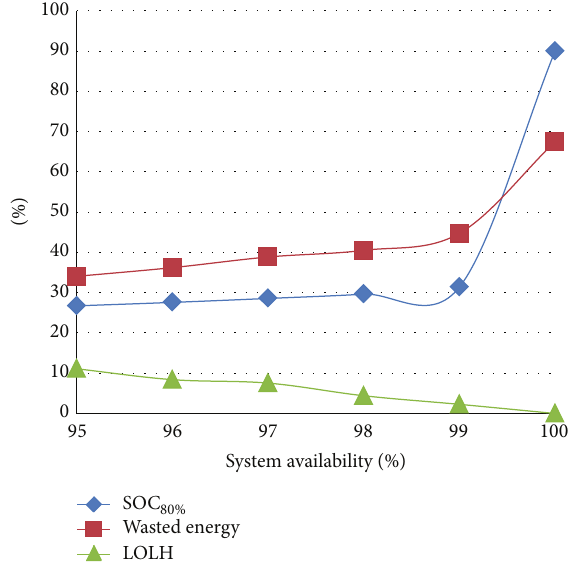
Figure 2: PV systems